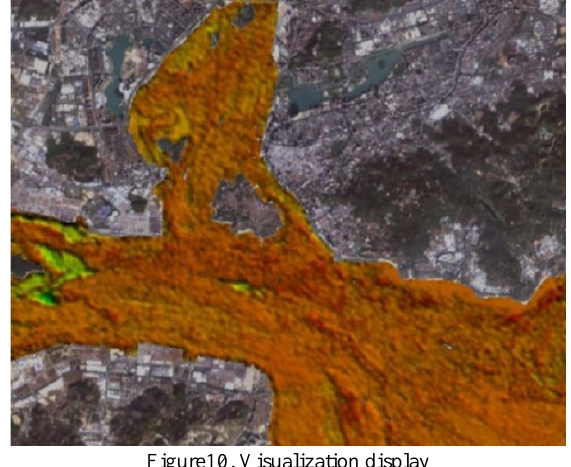
Figure10. Visualization